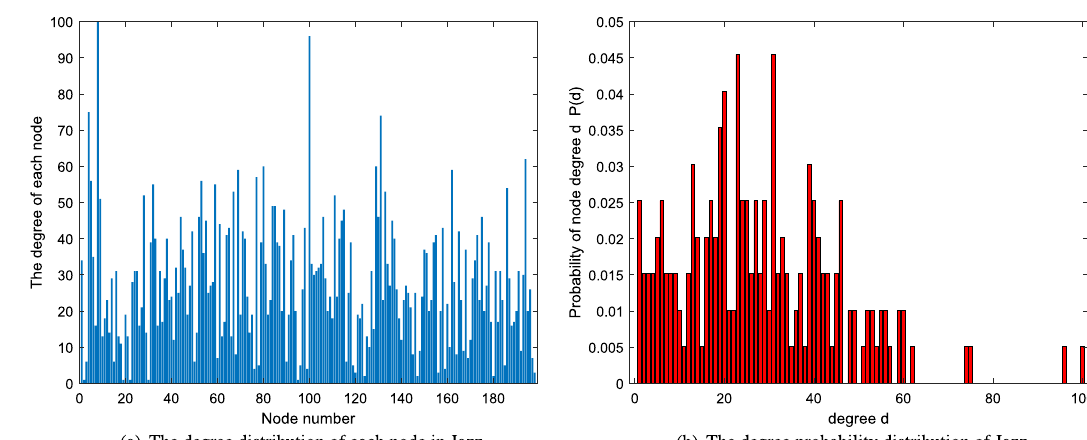
Figure 3. The degree distribution of network Jazz.